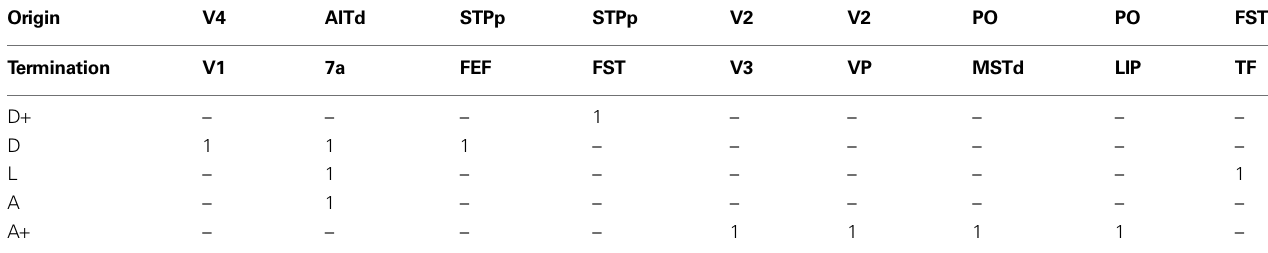
Table 3 | The 9 constraints that are violated by all 10 sets for both objectives. The number 1 means the corresponding connection is classifi ed as D + , D, L, A or A + .